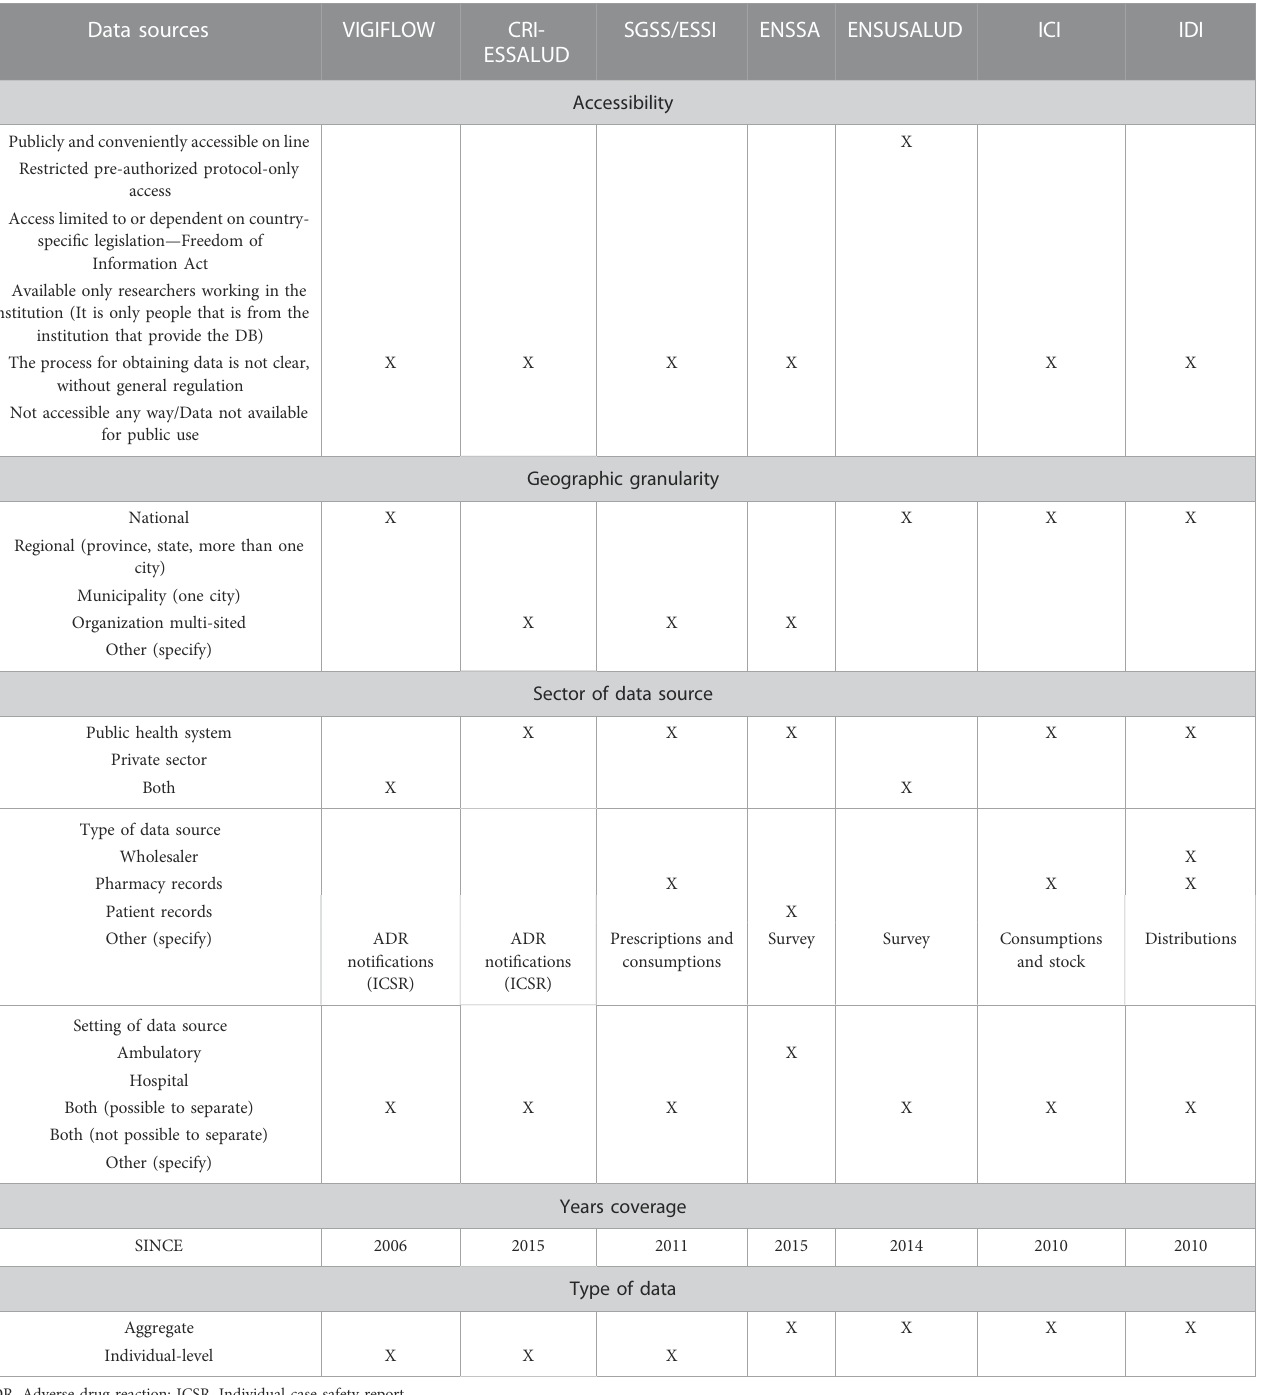
TABLE 2 Characteristics of data sources identi fi ed for DUR in